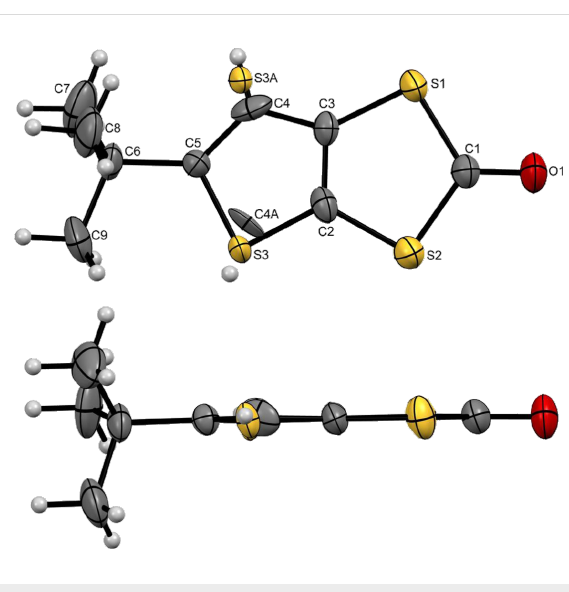
Figure 2: ORTEP view and atomic numbering scheme of I with thermal ellipsoids at 50% probability level.